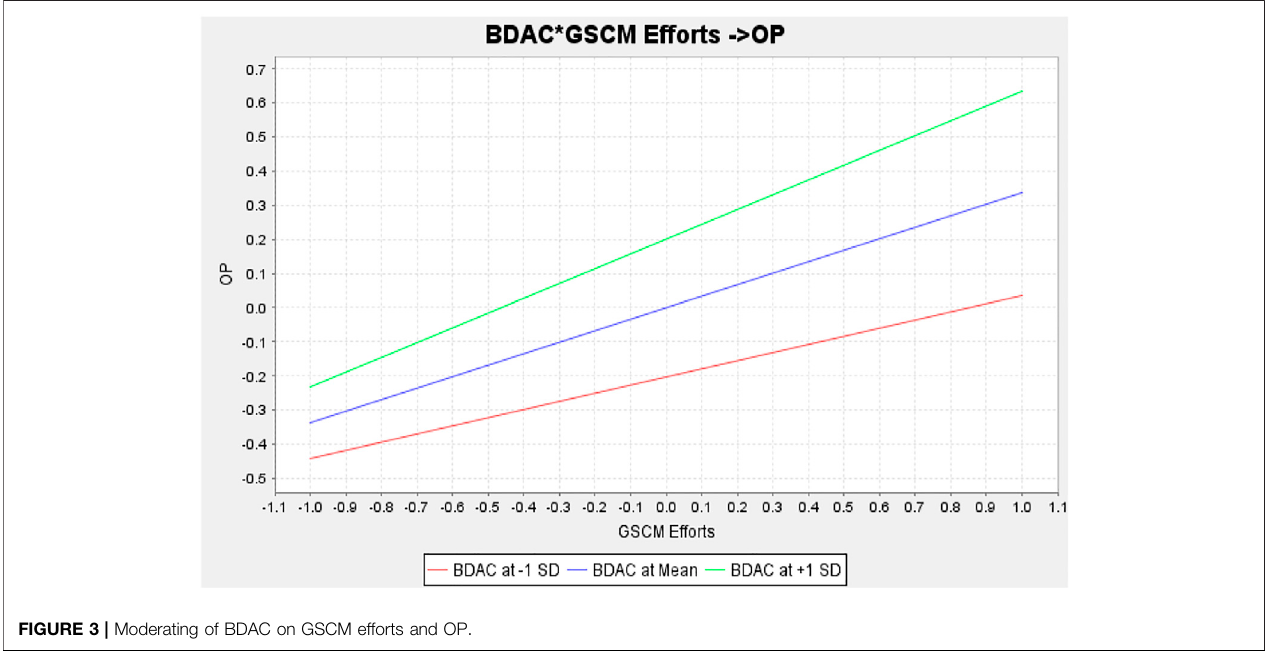
FIGURE 3 | Moderating of BDAC on GSCM efforts and OP.